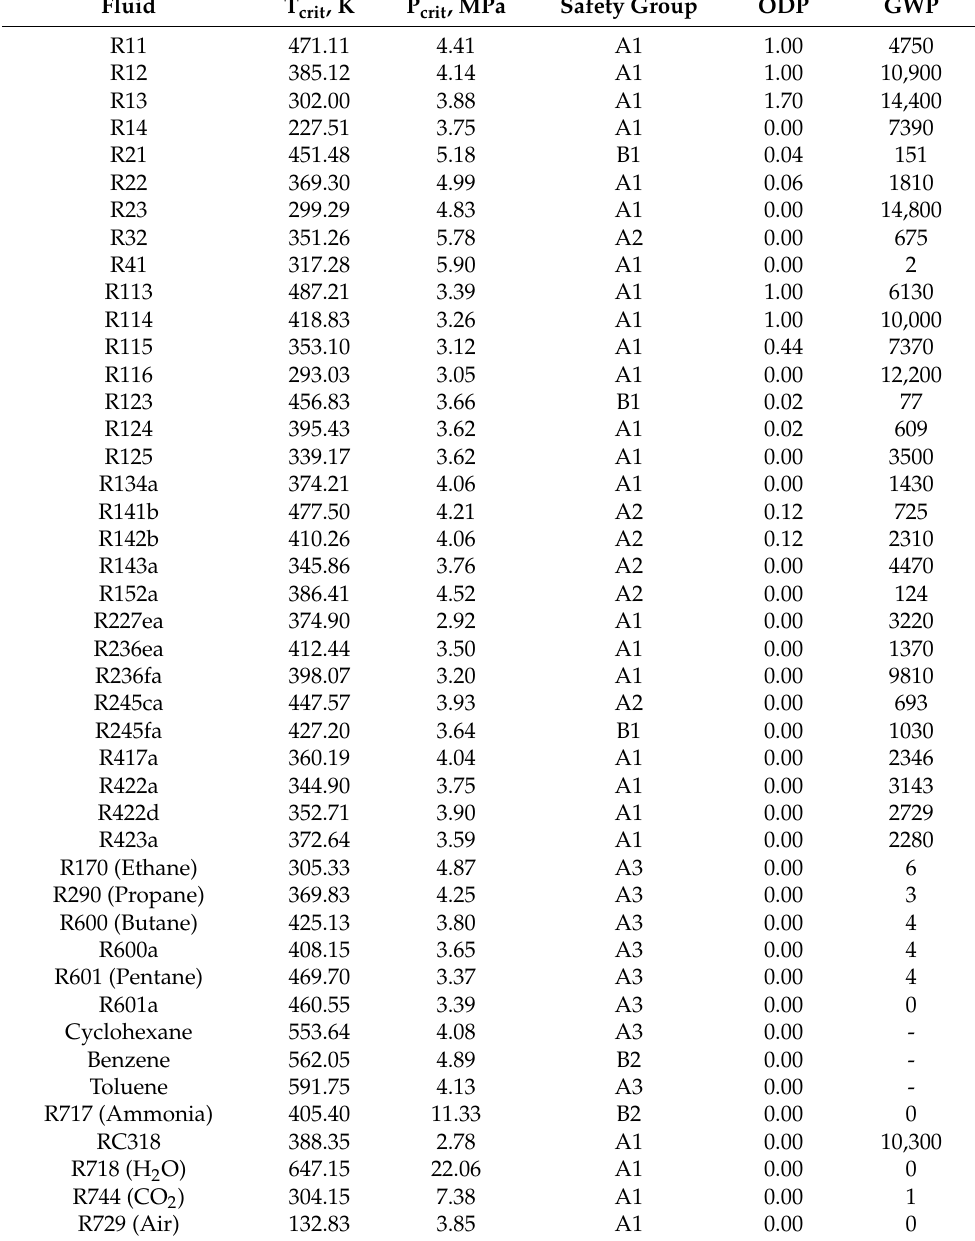
Table 2. Low-temperature cycle working fluids’ physical and environmental properties.